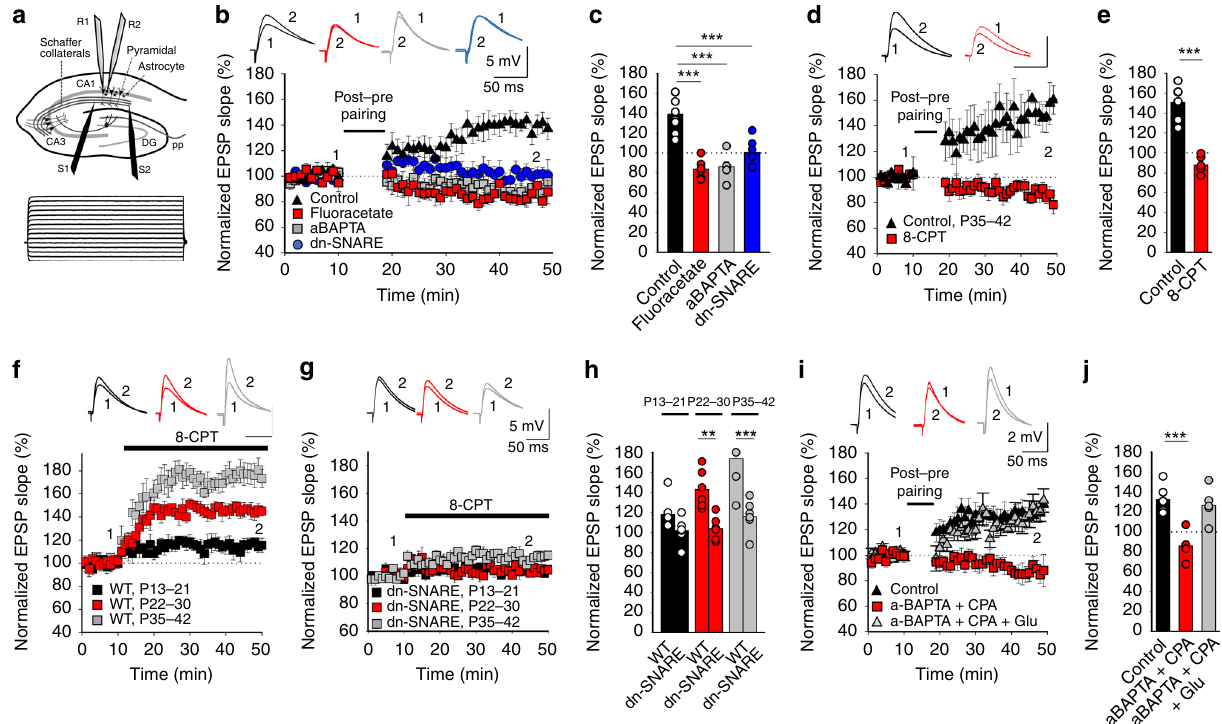
Fig. 5 Astrocytes and astroglial adenosine and glutamate involvement in t-LTP. Astrocytes are required for t-LTP. a Scheme showing the general experimental set-up: R1 and R2, recording electrodes; S1 and S2, stimulating electrodes; and voltage responses of an astrocyte shown in current clamp. b Time course of t-LTP induction in control conditions (black triangles, n = 8), and of the loss of t-LTP in the presence of fl uoroacetate (10 m M , red squares, n = 6), in BAPTA-treated astrocytes (20 m M , gray squares, n = 6) and in dnSNARE mutant mice (blue circles, n = 6). The traces show the EPSP before (1) and 30 min after pairing (2). c Summary of the results. *** p < 0.001, One-way ANOVA + Holm – Sidak. d Presynaptic A 1 R-mediated inhibition driven by adenosine released by astrocytes increases with maturation. Time course of t-LTP induction in control conditions (black triangles, n = 6), and of the loss of t-LTP in 8-CPT-treated slices (2 µ M , red squares, n = 6). The traces show the EPSP before (1) and 30 min after pairing (2). Scale bars: 5 mV, 50 ms. e Summary of the results. *** p < 0.001, two-sided Student ’ s t test. 8-CPT gradually increases the evoked EPSP slope at P13 – 21 (black squares, n = 7), P22 – 30 (red squares, n = 6) and P35-42 (gray squares, n = 6) in WT f but not in dn-SNARE mice (P13 – 21: black squares, n = 6; P22 – 30: red squares, n = 6; P35 – 42: gray squares, n = 7) g . h Summary of the results. ** p < 0.01; *** p < 0.001, two-sided Student ’ s t test. i The release of glutamate and adenosine by astrocytes is necessary for presynaptic t-LTP induction. Time course of the effect of post-before-pre pairing in control conditions (black triangles, n = 6), and in slices with BAPTA loaded into astrocytes and exposed to CPA (50 n M , red squares, n = 6), or slices with BAPTA loaded astrocytes exposed to CPA and glutamate puffs (100 µ M , gray triangles). Insets: The traces show the EPSPs before (1) and 30 min after pairing (2). j Summary of the results. *** p < 0.001. One-way ANOVA + Holm – Sidak. The error bars represent the S.E.M. Source data are provided as a Source Data fi